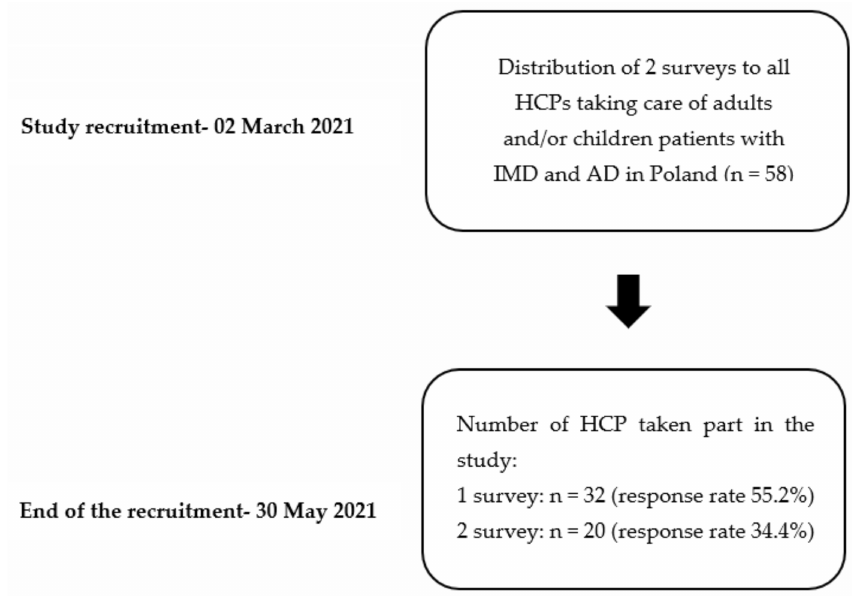
Figure 1. Flowchart of the study (HCP—health care providers; IMD—inherited metabolic disorders; AD—autoinflammatory